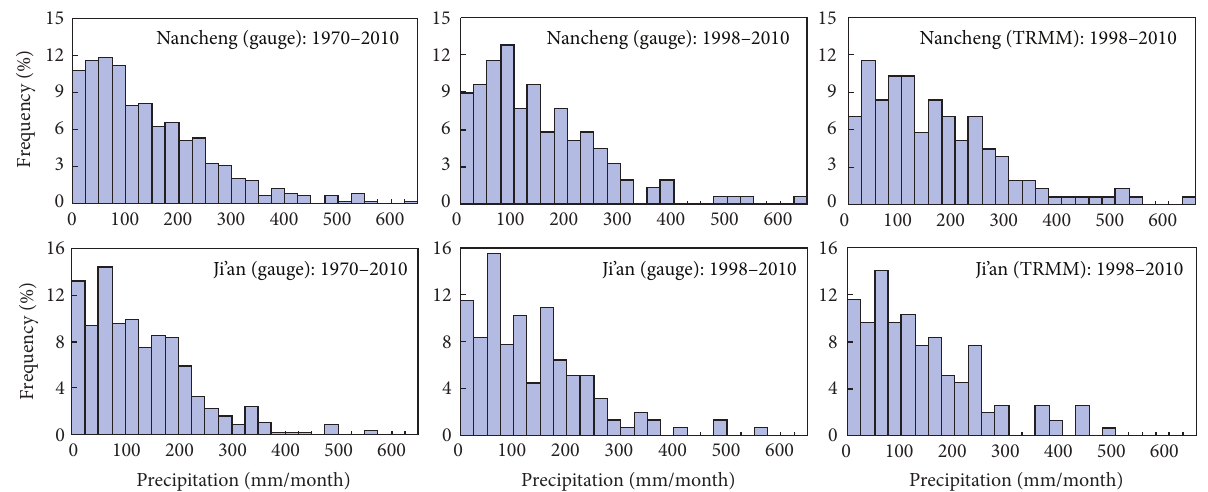
Figure 2: Comparison of histogram of frequencies for the long and short period data at Nancheng and Ji’an station.